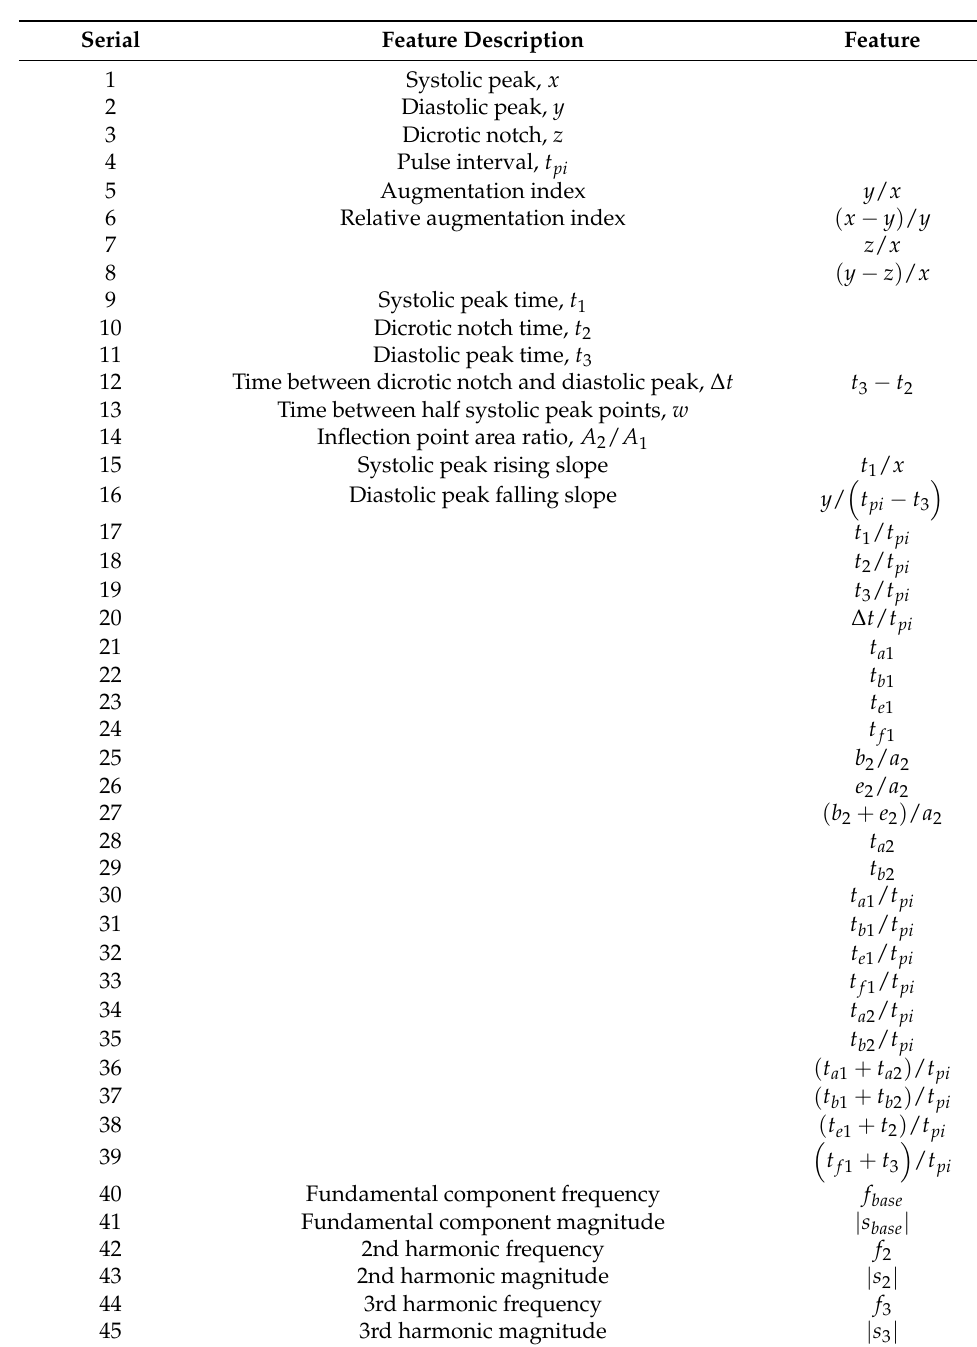
Table A1. Table of the features used to calibrate the